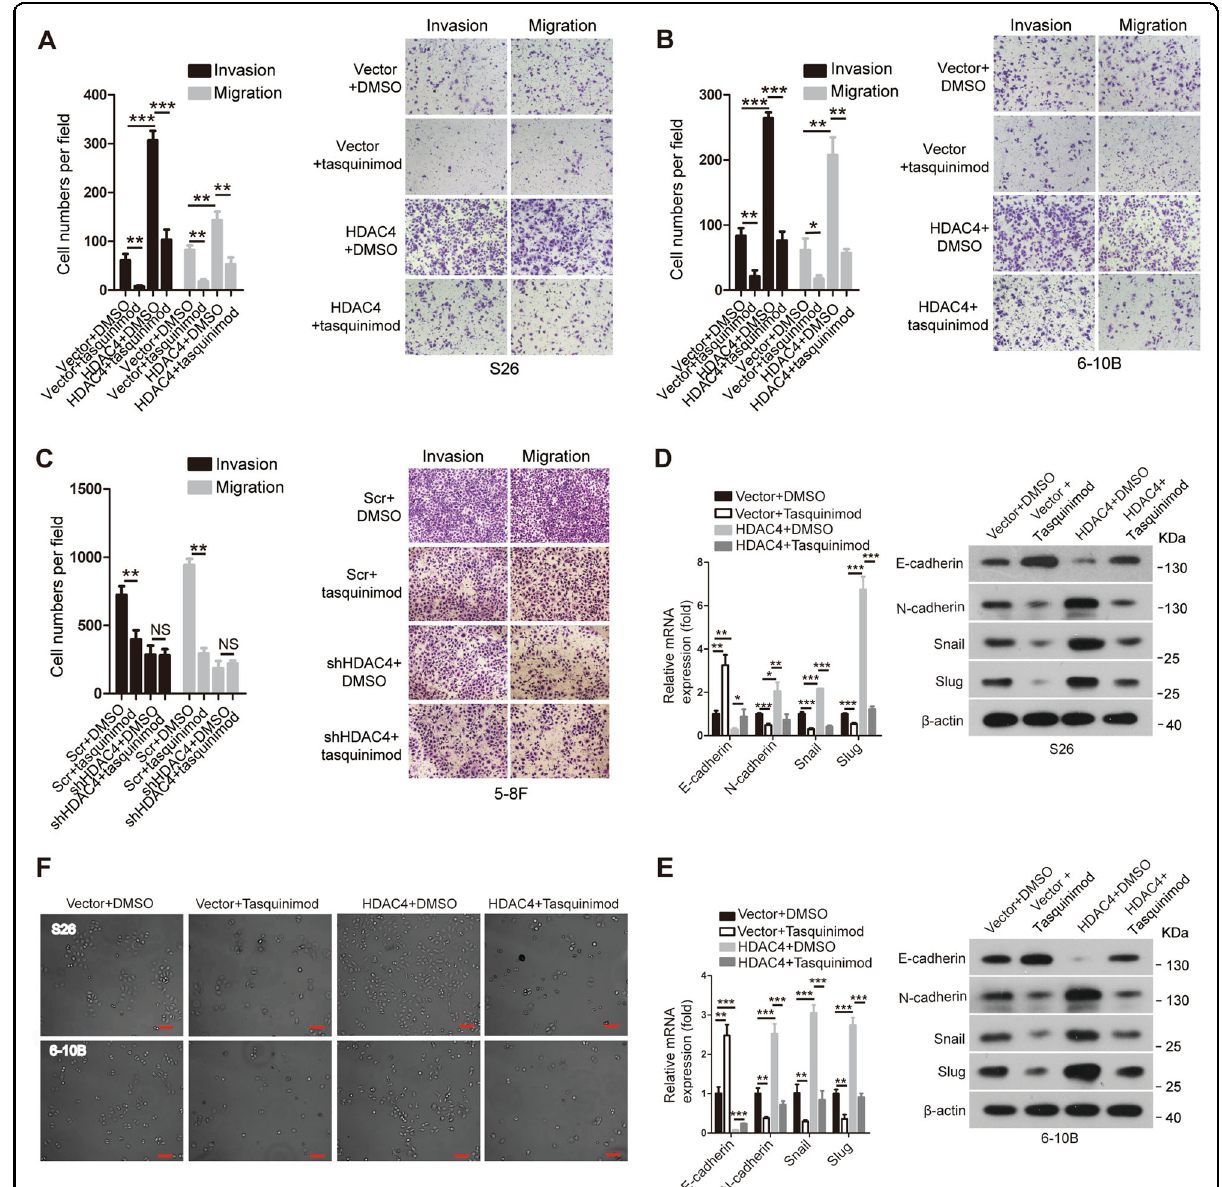
Fig. 6 Tasquinimod suppresses the HDAC4-induced promotion of cell migration and invasion in vitro. A – C The abilities of cell invasion and migration were determined via Transwell assays in the indicated stable cell lines after treatment with 5 μ M tasquinimod or vehicle (DMSO) for 48 h. The images on the right are representative images, and the images on the left are the statistical results. The data are presented as the means ± SD of three independent experiments. Student ’ s t -test, * P < 0.05, ** P < 0.01, *** P < 0.001. NS: nonsigni fi cant. D , E The mRNA and protein levels of EMT- related genes were determined by qRT-PCR (left) and western blotting (right), respectively, in the indicated cells treated with 5 μ M tasquinimod or DMSO for 48 h. GAPDH and β -actin were used as loading controls. The data are presented as the means ± SD of three independent experiments. Student ’ s t -test, * P < 0.05, ** P < 0.01, *** P < 0.001. F Representative phase-contrast images of S26 and 6-10B cells after treatment with 5 μ M tasquinimod or DMSO for 48 h. The scale bar represents 50 μ